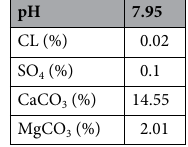
Table 2. Chemical properties of the clayey soil.